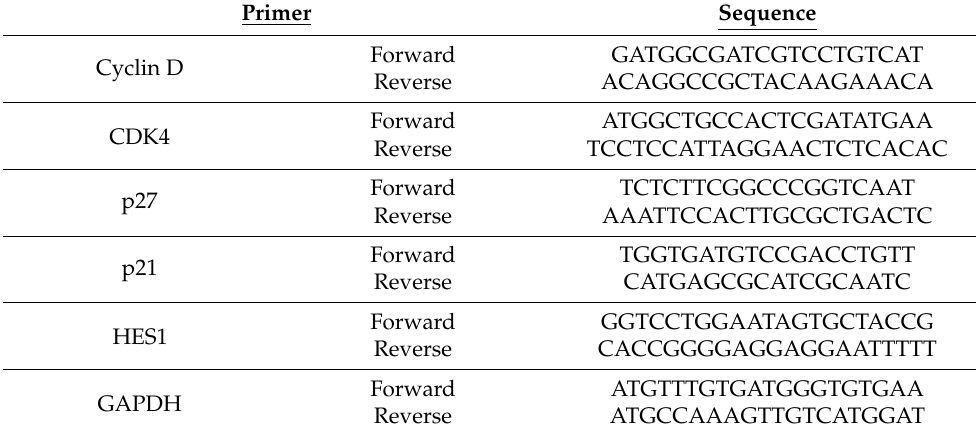
Table 1. Primers used for gene expression